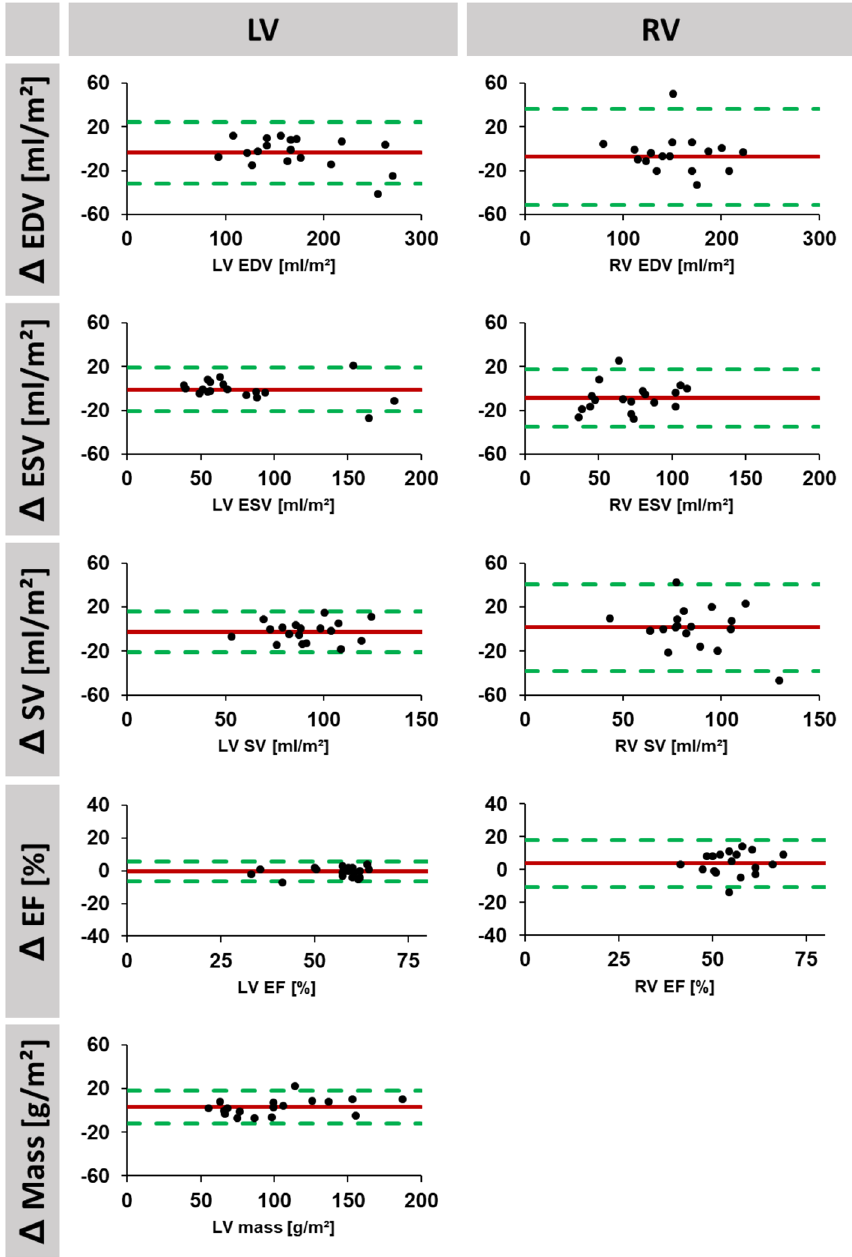
Figure 2. Agreement of short axis volume assessments based on fully automated analyses. Bland Altman plots are shown for interstudy reproducibility of left (LV) and right (RV) ventricular end-diastolic (EDV) and -systolic (ESV) as well as corresponding stroke volume (SV) and ejection fraction (EF). LV assessments also included LV mass. (Δ = difference for interstudy measurements. Red: bias; green: limits of